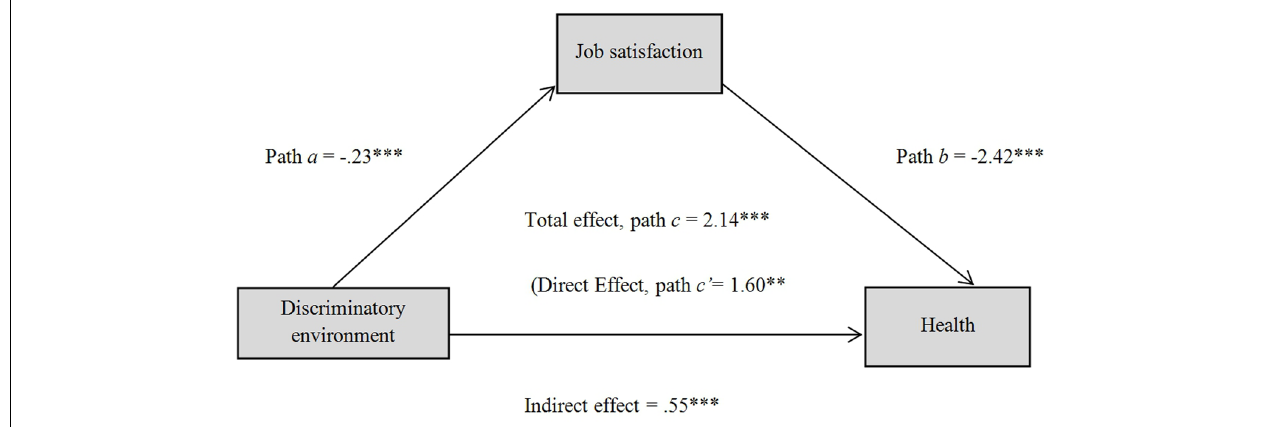
FIGURE 2 | Mediating effect of job satisfaction on the association between discriminatory environment and health for blue collars ( ∗∗ p < 0.01; ∗∗∗ p <